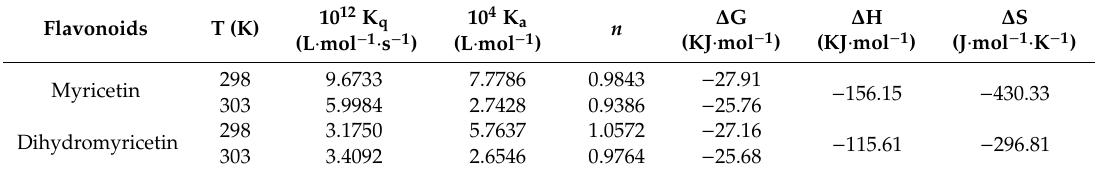
Figure 1. Effects of myricetin and dihydromyricetin on the fluorescence spectra of α -glucosidase at 25 and 30 °C (FS: Fluorescence Spectrum). Table 2. The quenching constants, binding constants, and thermodynamic parameters between two flavonoids and α -glucosidase at 298 and 303 K.